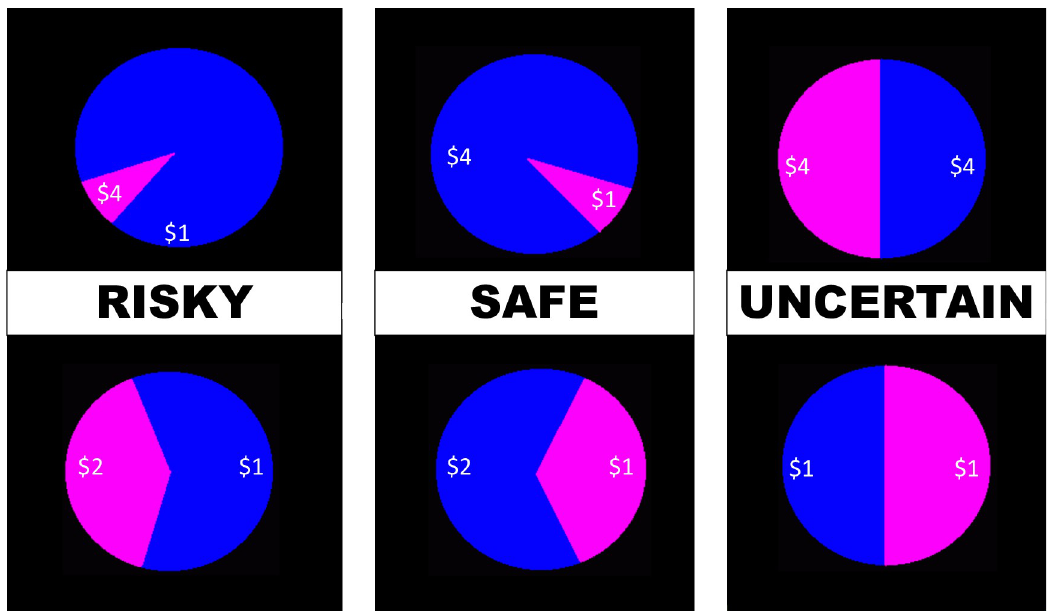
Fig 1. The Wheel of Fortune. The Wheel of Fortune, a computerized task used to measure responses to monetary rewards under risky, safe and uncertain conditions. 30/70 safe wheels, 30 represented the chance of winning CHF 0.50, and 70, CHF 1. The 50/50